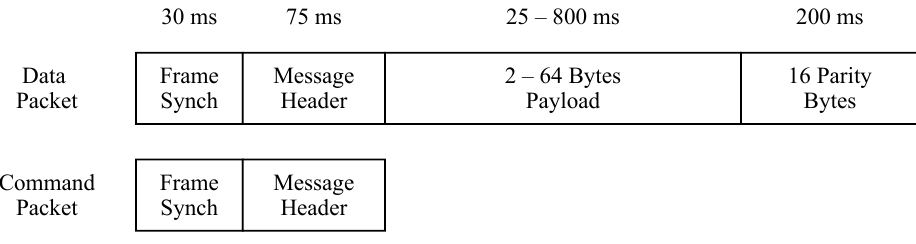
Figure 10. NMv3 packet